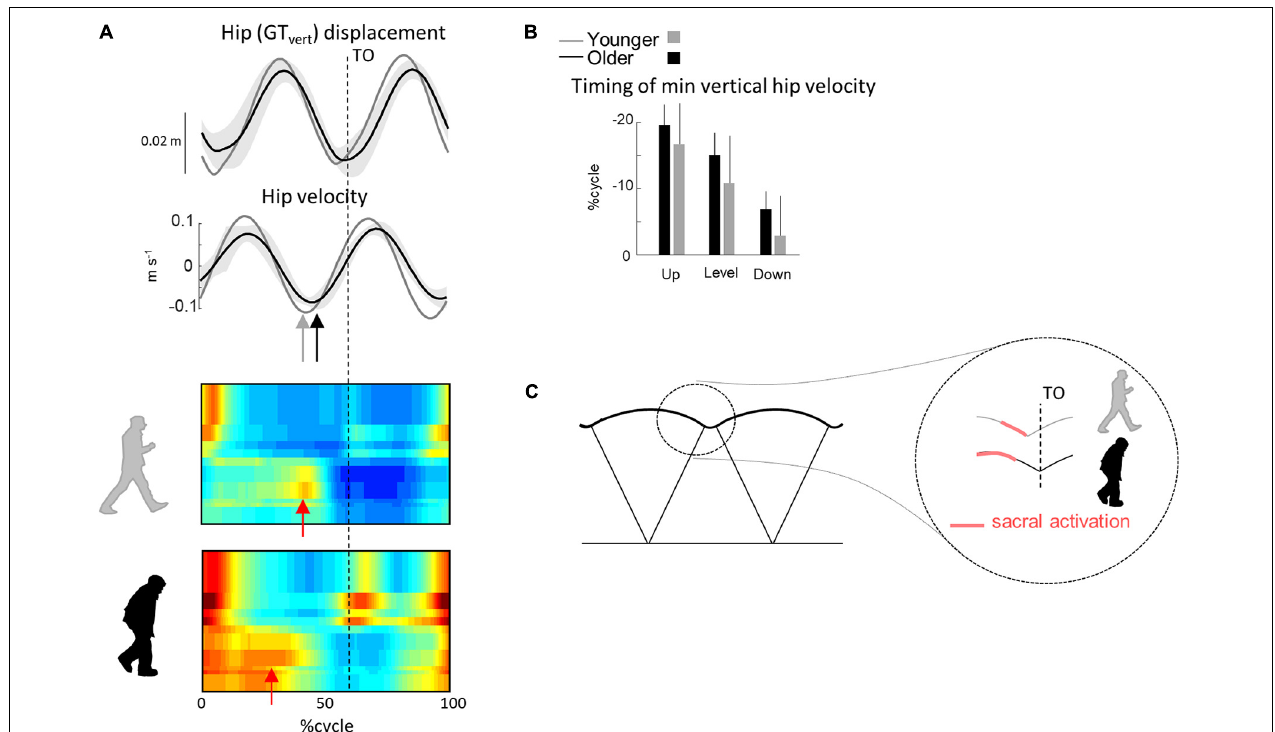
FIGURE 7 | Unilateral spatiotemporal spinal motor outputs computed from ensemble-averaged EMGs across all conditions. (A) Motor output (reported in µ V) is plotted as a function of gait cycle in young (top) and older (bottom) adults. The thin green and red lines correspond to the activation of the lumbar and sacral segments, respectively. The gray area is the sum of all segments and reflects the level of activation. (B) Average minimal and maximal level of activation of the spinal motor output, average FWHM, and timing of the maximal activation of the lumbar and sacral segments. (C) Illustration of step-to-step transition. Other indications as in Figure 2